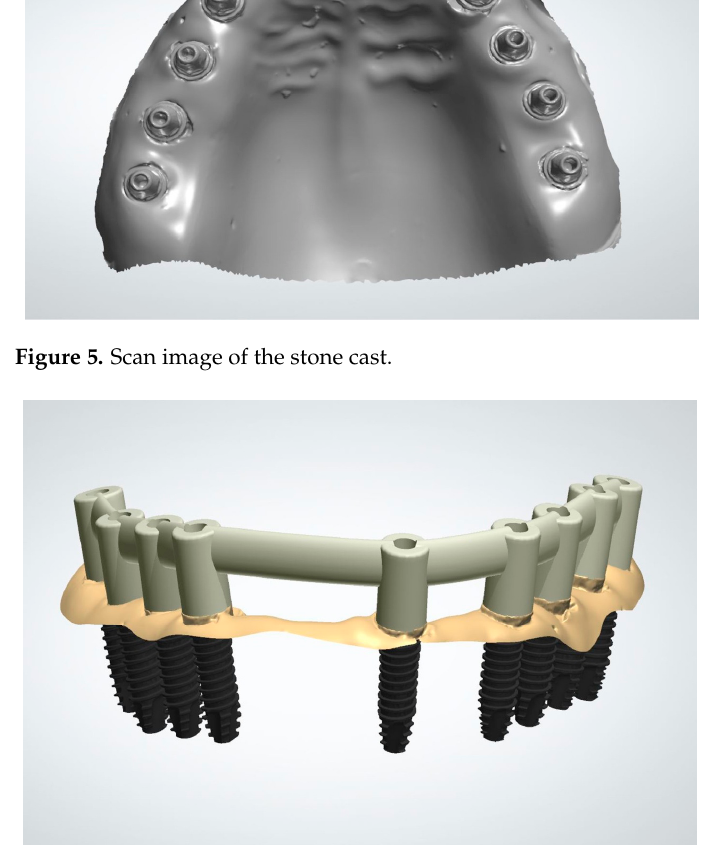
Figure 6. Designed metal framework.